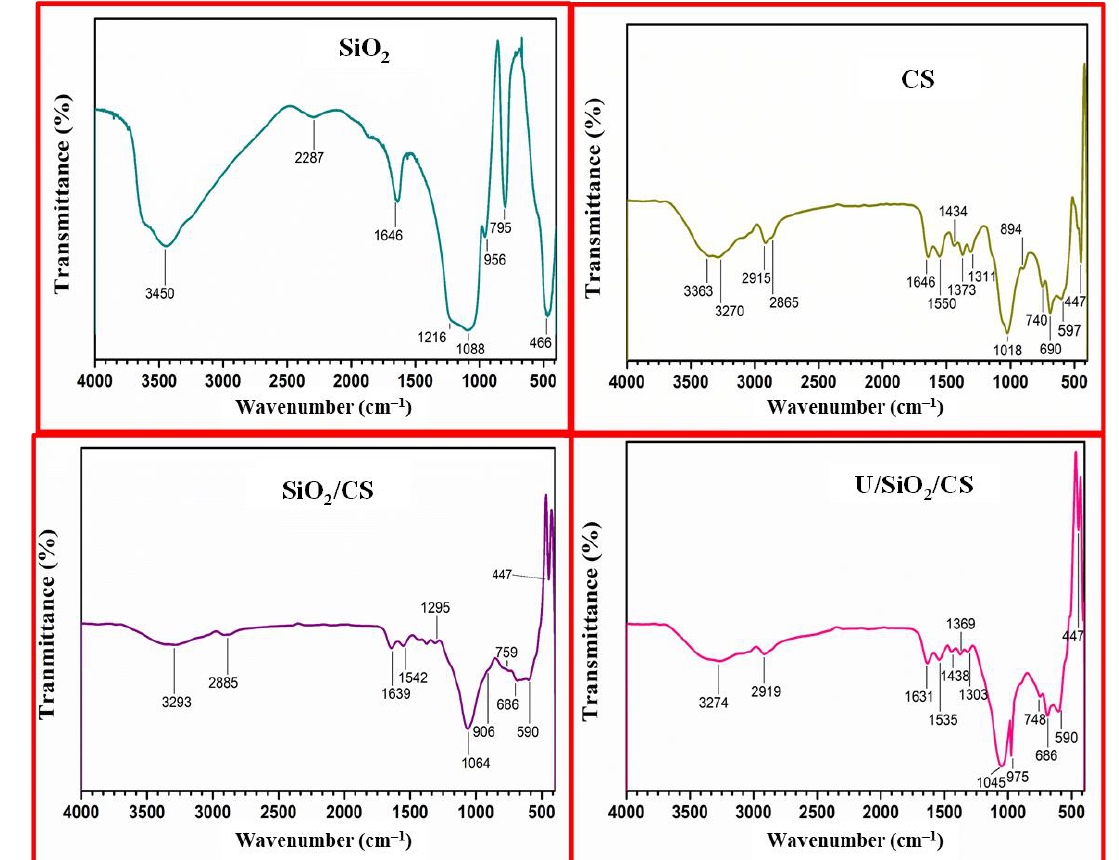
Figure 4. SiO 2 , CS, SiO 2 /CS, and U/SiO 2 /CS FTIR spectra.